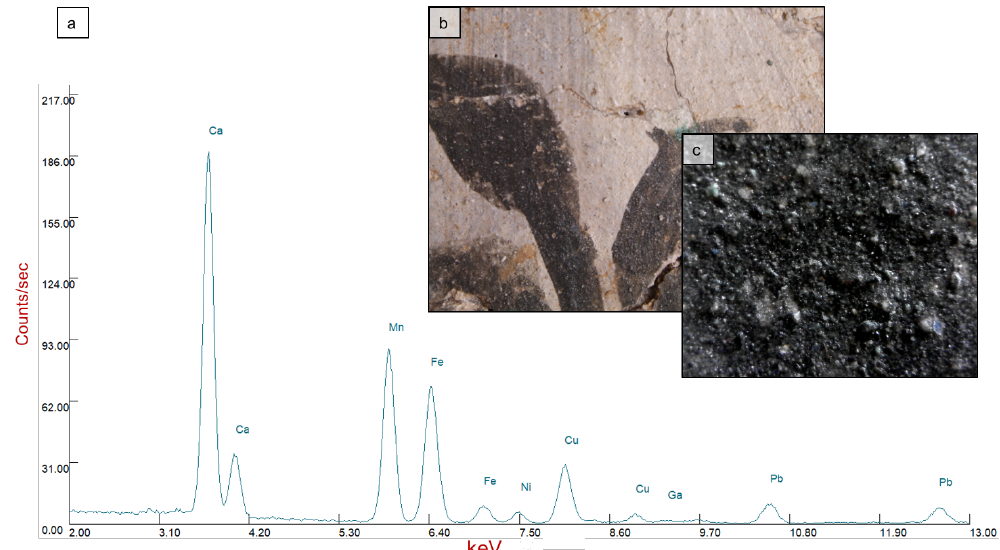
Figure 18. From a figurative painting from the House of Aion (E5), ( a ) an XRF spectrum taken of a black wreath leaf shows characteristic X-ray emission of Mn; ( b ) detail and ( c ) photomicrograph (250 × ) of the wreath leaf shows blue particles within the black matrix, most likely Egyptian blue, the source of the Cu peaks in the XRF